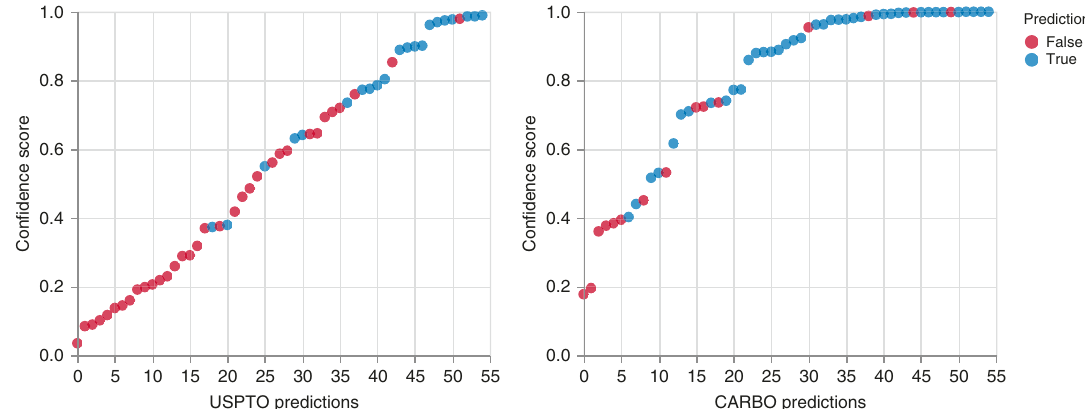
Fig. 6 Analysis of prediction con fi dence scores. Predictions (ordered by con fi dence score) for the experimental assessment. Source data are provided as a Source Data fi